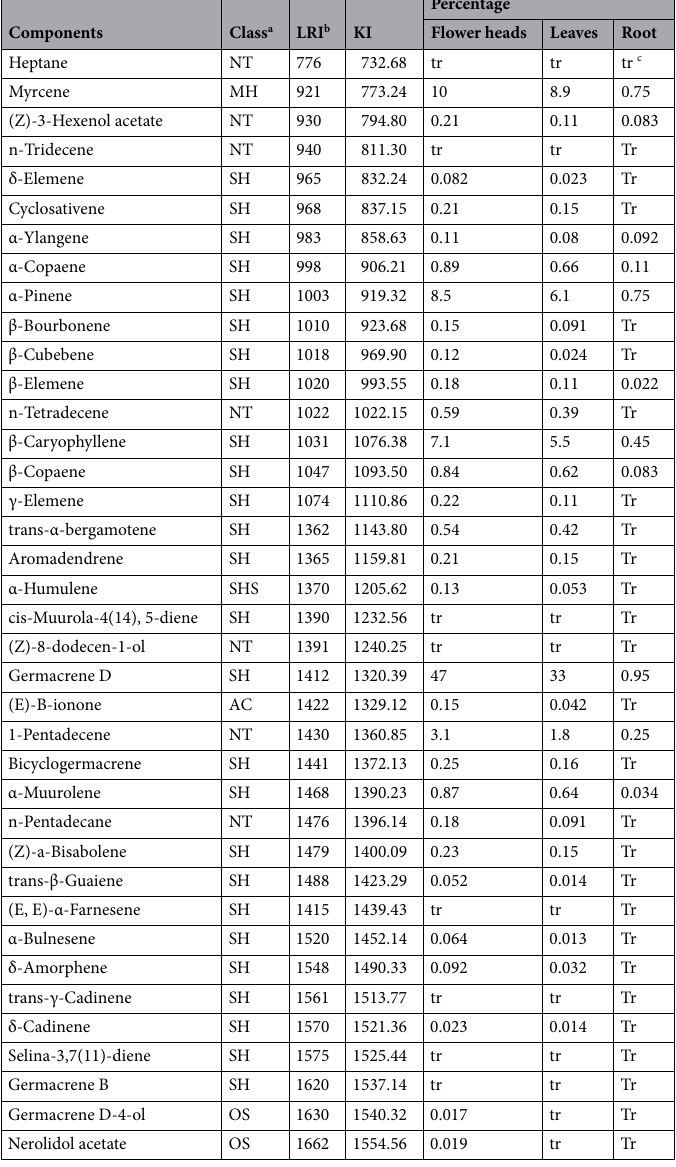
Table 4. Essential oil chemical composition of E.purpurea grown at the best growing media at 70:30 NO 3- / NH 4+ ratio. a Class: AC apocarotenoids; MH monoterpene hydrocarbons; SH sesquiterpene hydrocarbons; NT non-terpenes; OS oxygenated sesquiterpenes. b LRI Linear Retention Index. c Trace (below 0.01%); KI Kovats